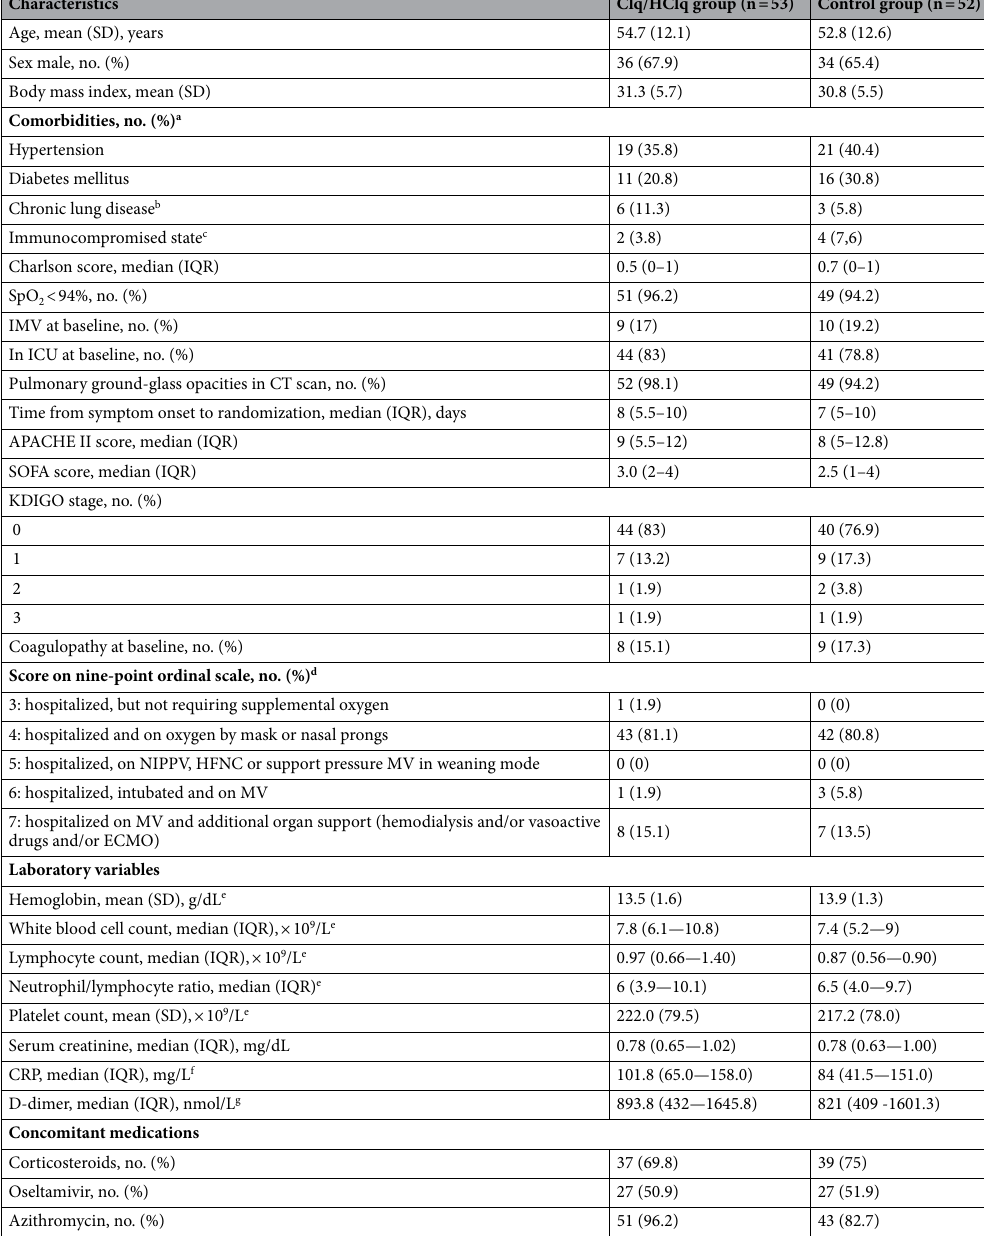
Table 1. Baseline characteristics and concomitant treatments during hospitalization in the modified intention to treat population. SpO 2 pulse oxygen saturation; ICU intensive care unit; MV mechanical ventilation; IMV invasive ventilation; CT computed tomography; APACHE II Acute Physiology and Chronic Health disease Classification System II; SOFA Sequential Organ Failure Assessment; KDIGO Kidney Disease: Improving Global Outcomes; HFNC high-flow nasal cannula; NIPPV noninvasive positive-pressure ventilation; ECMO extracorporeal membrane oxygenation; CRP C-reactive protein, SD standard deviation; IQR interquartile range; Clq chloroquine; HClq hydroxychloroquine. a No participants had any of the following comorbidities: chronic renal failure; peripheral vascular insufficiency; or heart, liver, rheumatic, or hematological disease. b Considering asthma or chronic obstructive pulmonary disease. c Considering cancer or human immunodeficiency virus infection. d Only hospitalized patients were eligible for the trial; therefore, patients who had scores of 0, 1, 2 or 8 on a nine-point ordinal scale were not eligible. e One missing data point in the Clq/HClq group. f Three missing data points in the Clq/HClq group and one missing data point in the control group. g 27 missing data points in the Clq/HClq group and 25 in the control